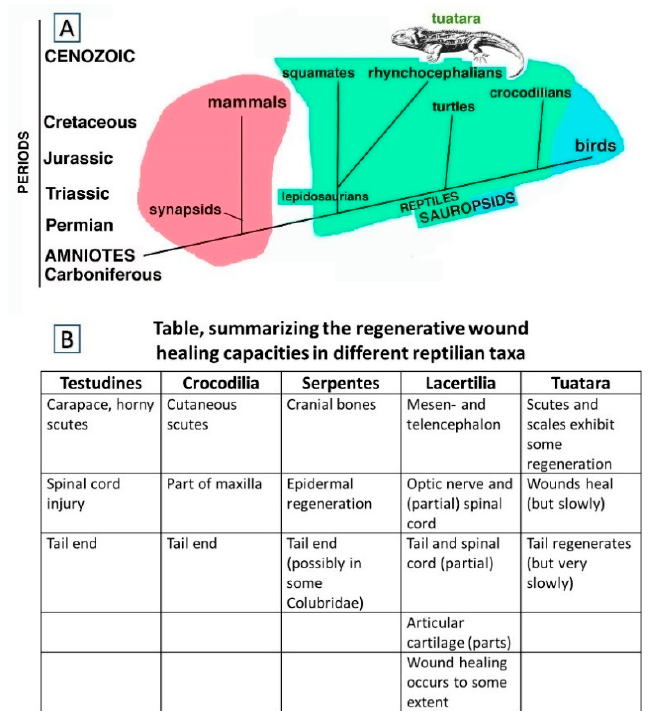
Figure 1. ( A ), Schematic cladogramme indicating the two main amniote radiation paths from basal amniotes, i.e., synapsids-mammals (pink) and sauropsids that include reptiles (green) and birds (light blue). ( B ), Table indicating the main organ and tissues undergoing wound healing with scarring, regengrow and heteromorphic regeneration in different sub-orders of Reptiles.